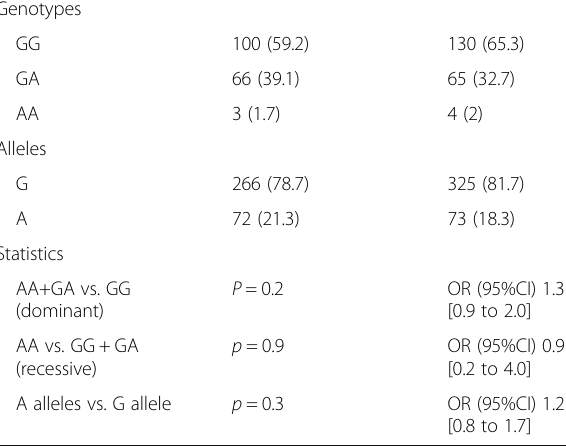
Table 3 Genotype frequencies of TNF- α -308 G/A in different species of leishmaniasis and healthy human controls